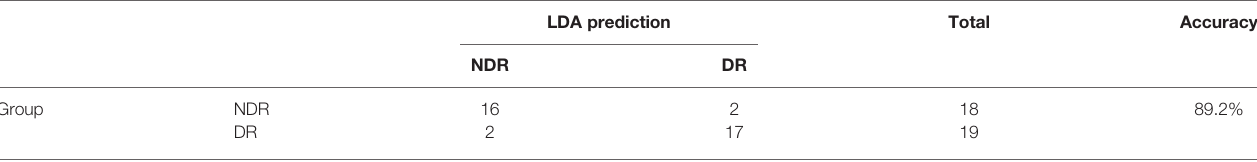
TABLE 1 | Leave-one-out cross validation of the linear discriminant analysis (LDA) model.